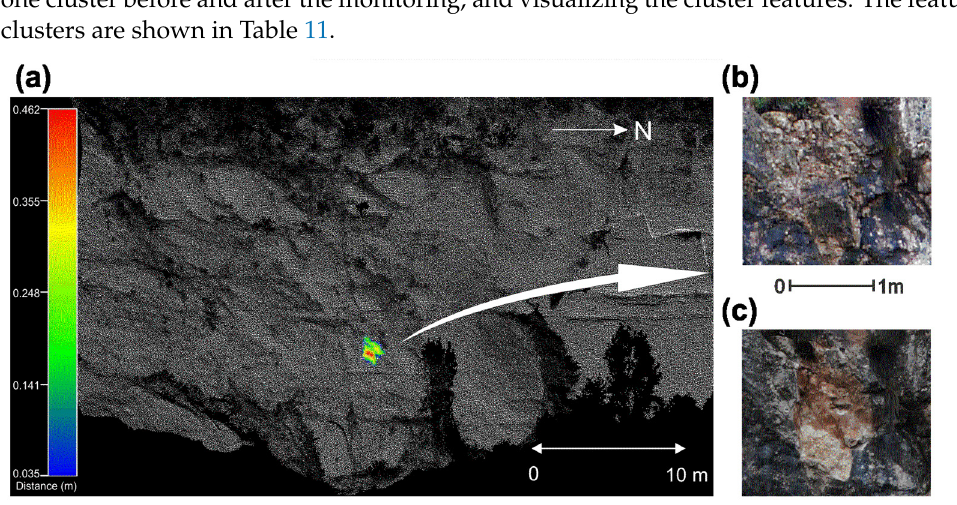
The total number of clusters labeled as “Candidate” and validated as rockfall events at Degotalls E during the monitoring period was 65. At Degotalls N the number of can- didates validated was 133, but 40 clusters of them correspond in fact, to only two large events occurred in December of 2008, therefore we assess 95 rockfalls (see Figure 10). This re-count is due to the configuration of the monitoring process focused on preventing the